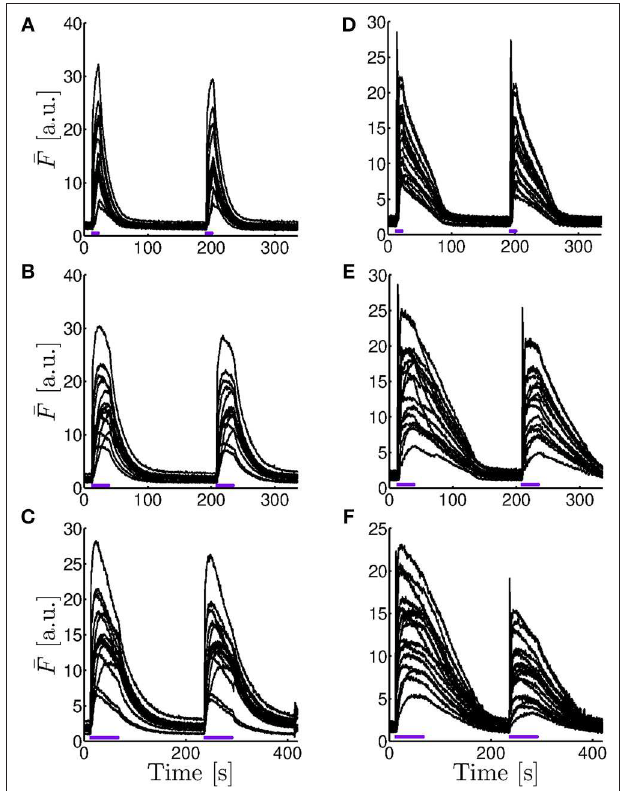
FIGURE 5 | Comparison of the fluorescence time course obtained in experiments performed for different UV pulses. Fluorescence averaged over subregions with similar basal fluorescence levels ( F k , Equation 1) as a function of time for experiments performed in an immature oocyte (A–C) and in an egg (D–F) in which two UV pulses of 11.2 s (A,D) , 28 s (B,E) , and 56 s (C,F) were applied to photo-release the caged IP 3 . The time elapsed between the end of the first flash and the beginning of the second was always s. The number of curves and, equivalently, of subregions, is n 15 in the oocyte (A–C) and = n 16 in the egg (D–F) =